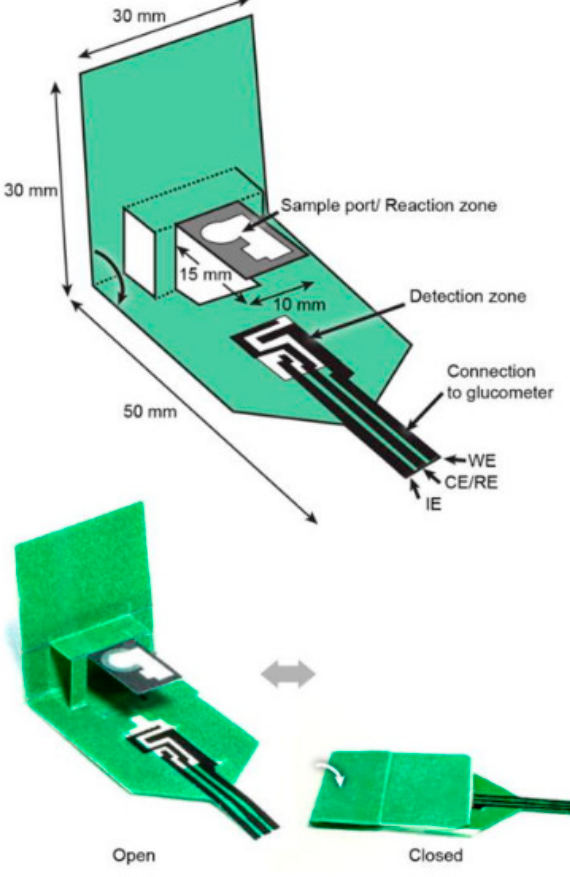
Figure 2. A 3D “pop-up” electrochemical paper-based sensor developed for analysis of beta-hydroxy- butyrate [62] .